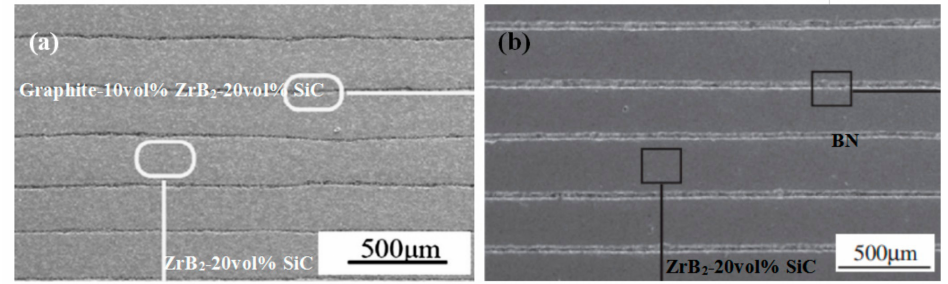
Figure 6. ( a ) Laminated ZrB 2 -SiC/graphite ceramic produced by tape-casting. Reproduced with per- mission from [66]. ( b ) ZrB 2 -SiC/BN ceramic produced by tape-casting. Reproduced with permission from